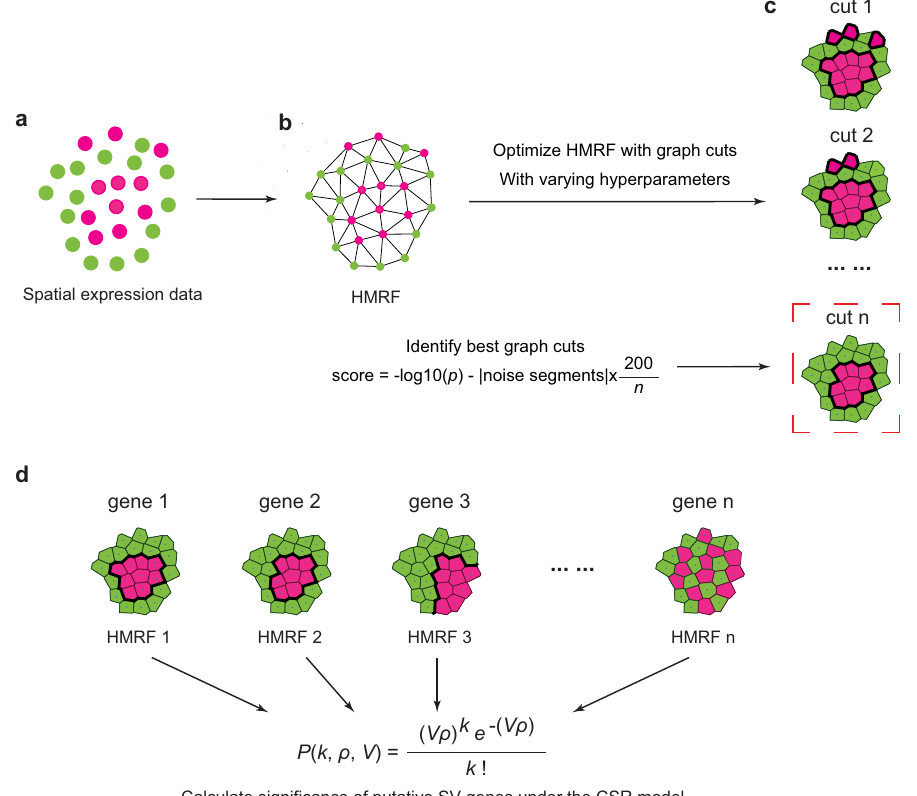
Fig. 1 | Overview of scGCO for SV gene identi fi cation. a A gene ’ s spatial expres- sion pattern. Each dot represents a cell and is placed according to its spatial coordinate. b Representingagene ’ sspatialexpressionwithhiddenMarkovrandom fi eld(HMRF). c OptimizingHMRFusinggraphcutsalgorithmwithdifferentsmooth factors and identifying the best graph cuts result that maximizes a score based on